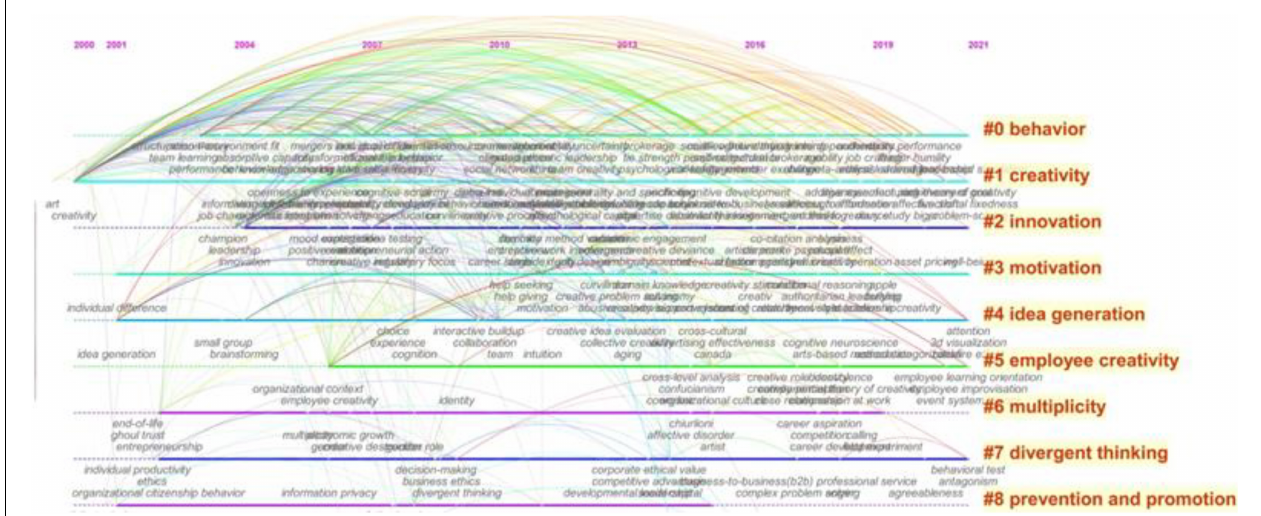
FIGURE 3 | Co-word clustering knowledge map of employee creativity research from 2000 to